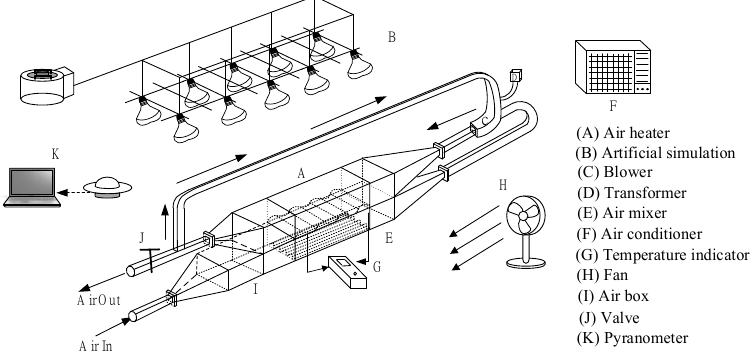
Figure 9. Experimental setup of a recycling cross-corrugated solar air collector ( Type C ).